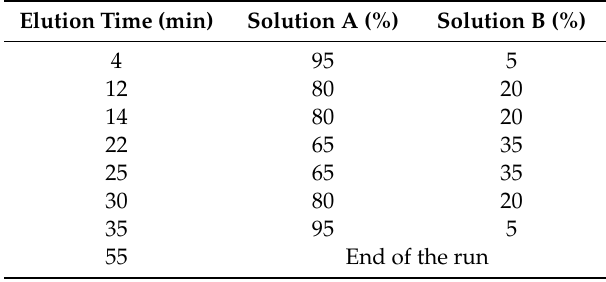
Table 1. Gradient profile of mobile phase. Solution A: 0.1% trifluoroacetic acid (TFA) in distilled water, Solution B: 0.1% TFA in